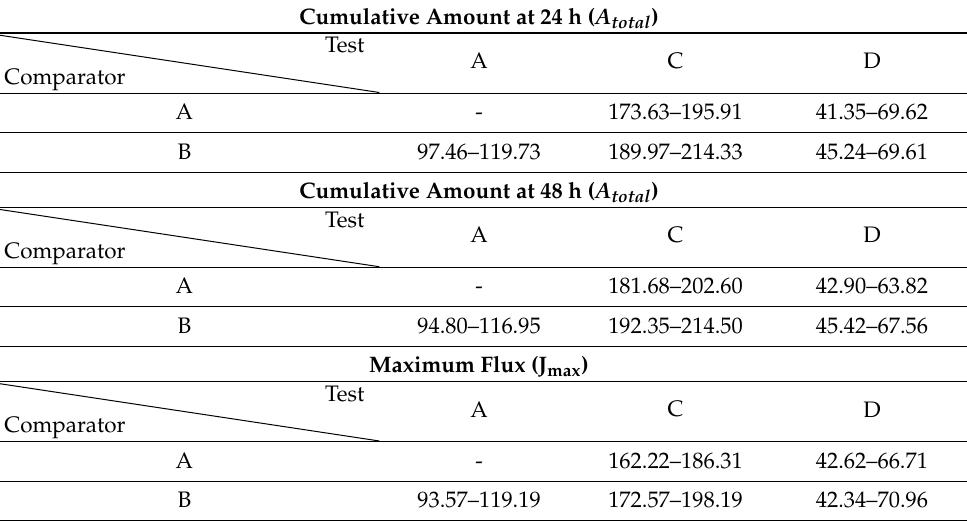
Table 5. Statistical analysis for A total results at 24 and 48 h, as well as J max between the test and comparator formulations (A and B) and between the test formulations (A, C, and D) themselves. (A—test product; B—comparator product; C—“negative control” with 200% strength of the test formulation; D—“negative control” with 50% strength of the test formulation). Results within the 80.00–125.00% range indicate